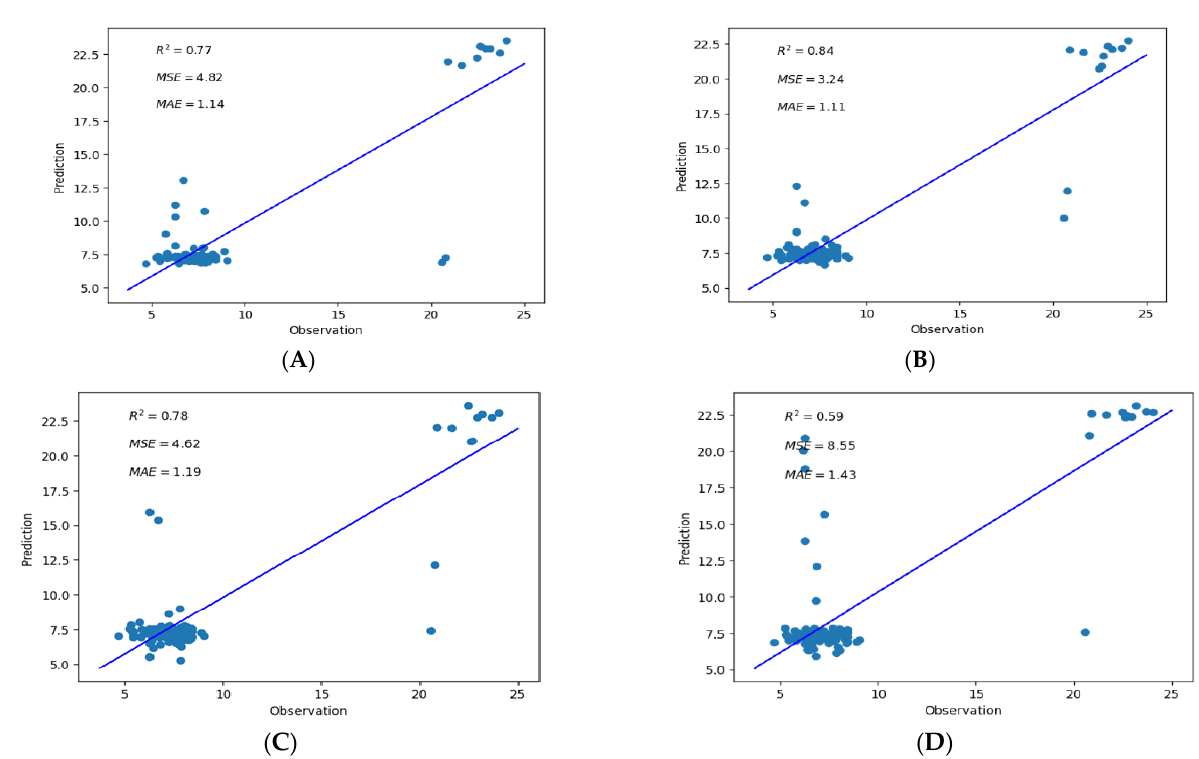
Figure 5. Scatter plots of the measured and estimated SMC derived from four ETD, SVM, RF, and XGBoost regression models using the Sentinel 2 MSI data. ( A ) SVR model, ( B ) ETD, ( C ) RF, ( D ) XGBoost.